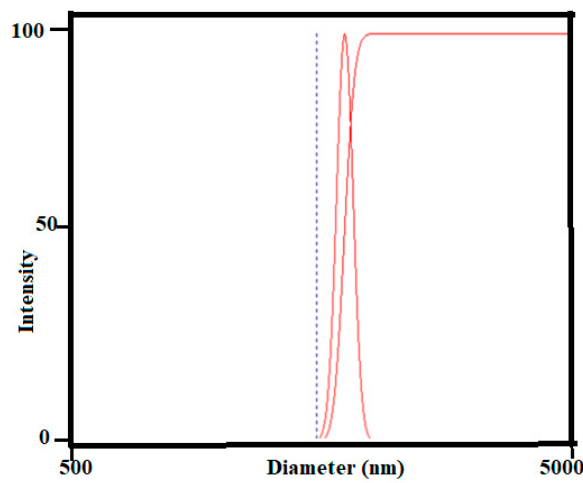
Figure 3. Dynamic light scattering (DLS) data of natural rubber latex (NRL) (average diameter = 637 nm with size polydispersity (PDI) = 0.005.